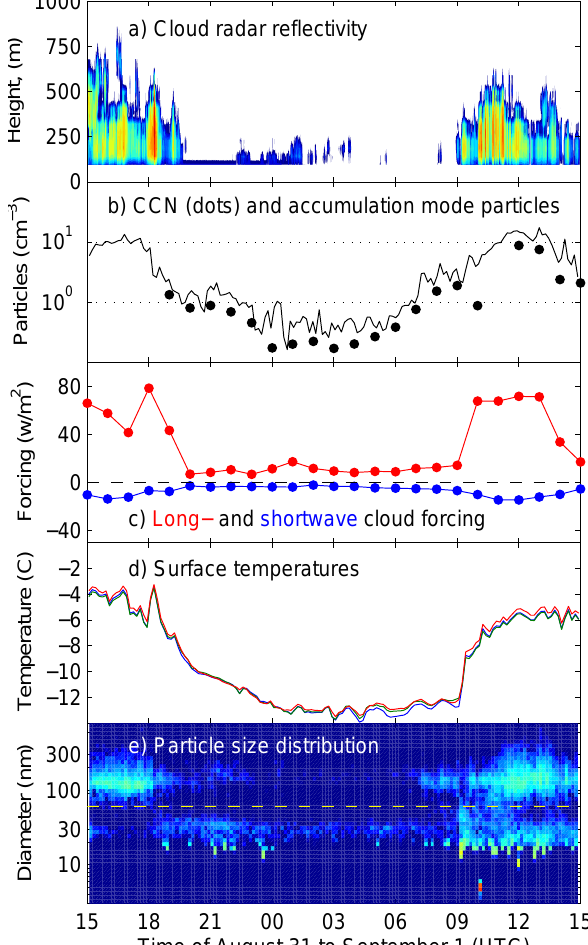
Fig. 3. Evolution of relevant measurements for a case of very low CCN number concentrations. The cloud radar is sensitive to both clouds and precipitation with the lowest measurement height at 105 m. Aerosols larger than approximately 60 nm are accumulation mode particles, the sum of which is shown in panel b) as a solid line, while the smaller sized mode seen below the yellow dashed line in panel e) is the Aitken mode Covert et al. (1996). Aitken mode particles are usually not sufficiently large to be CCN.